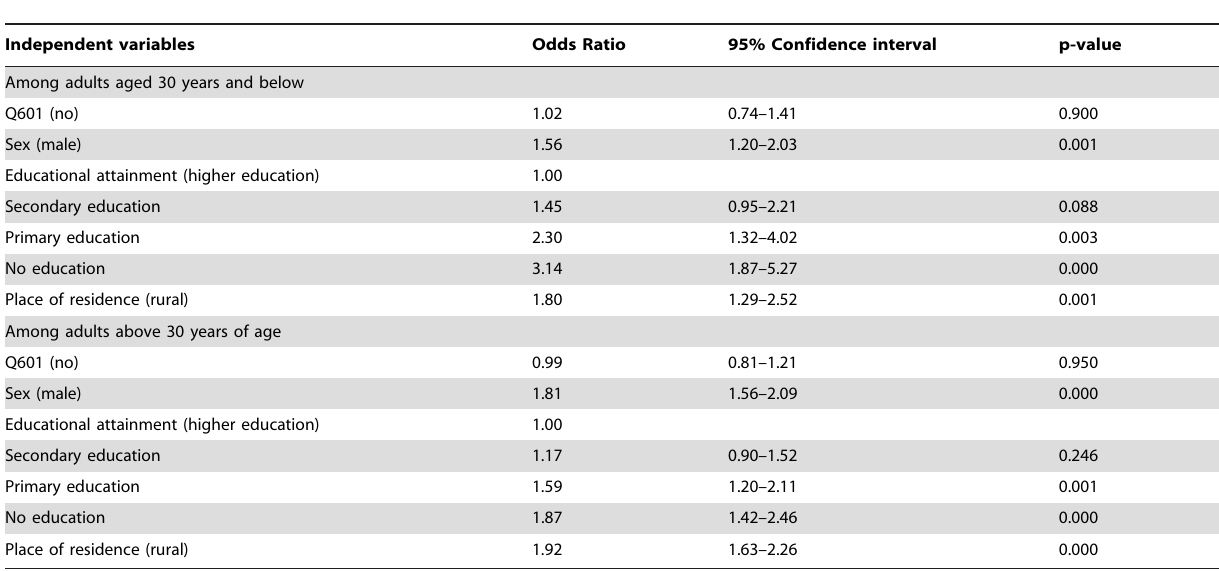
Table 3. Age-stratified multivariate logistic regression for the association between HCV antibody prevalence as dependent variable and question 601 (Q601) ‘‘Have you ever heard of hepatitis C illness?’’ controlling for sex, educational attainment and place of residence.